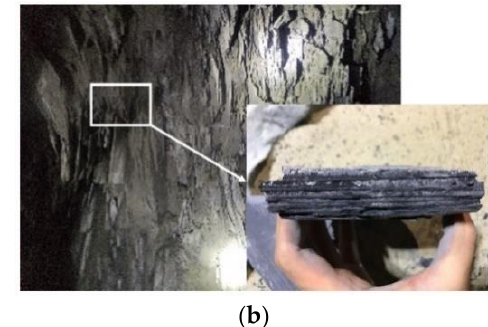
Figure 2. Different structure types of carbonaceous slate: ( a ) lump structure; ( b ) layer structure.